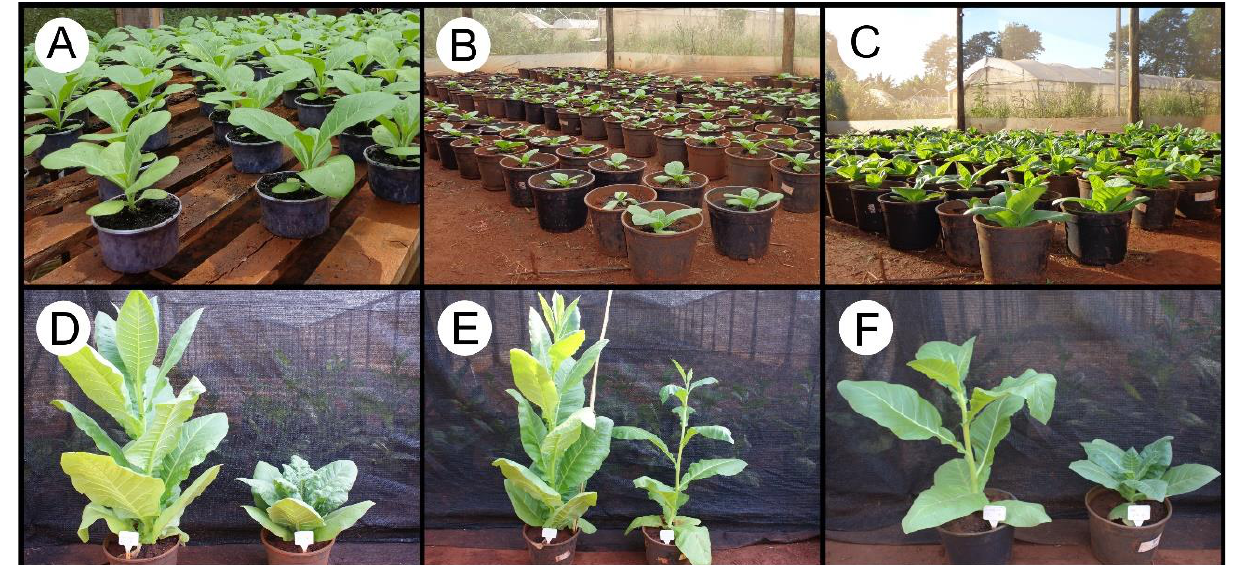
Figure 2. Representative images of tobacco plants with variations in phenotype. ( A – C ) Differentiated growth stages of tobacco plants in the greenhouse. ( D – F ) Effects of gibberellic acid (GA 3 ; elongated plants) or paclobutrazol (PAC, shorter plants) on the growth plants under different light conditions (high and low light, normal and etiolated phenotypes).